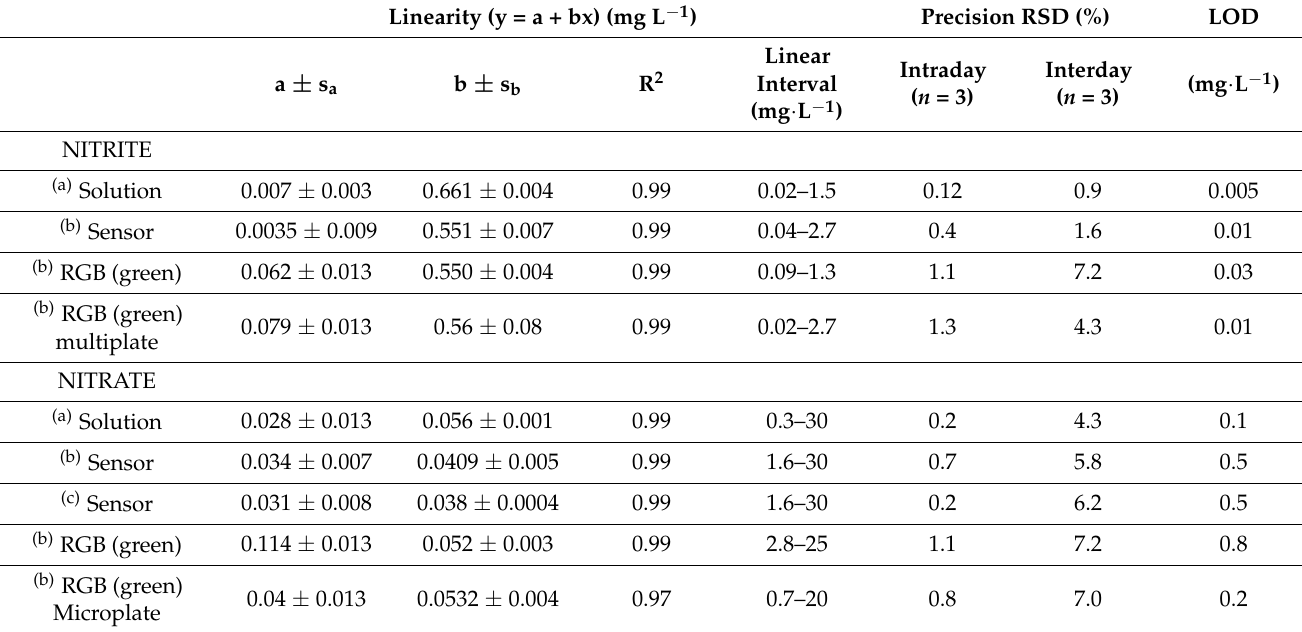
Table 2. Figures of merites for nitrite and nitrate. (a) All the reagents in solution; (b) by using the reagents entrapped in PDMS composite and ZnNPs dispersed; (c) by using the reagents entrapped in PDMS composite and ZnNPs retained in